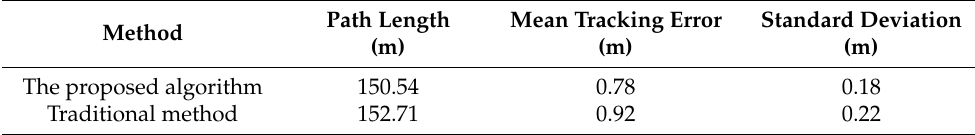
Table 2. Comparison results between the proposed and traditional